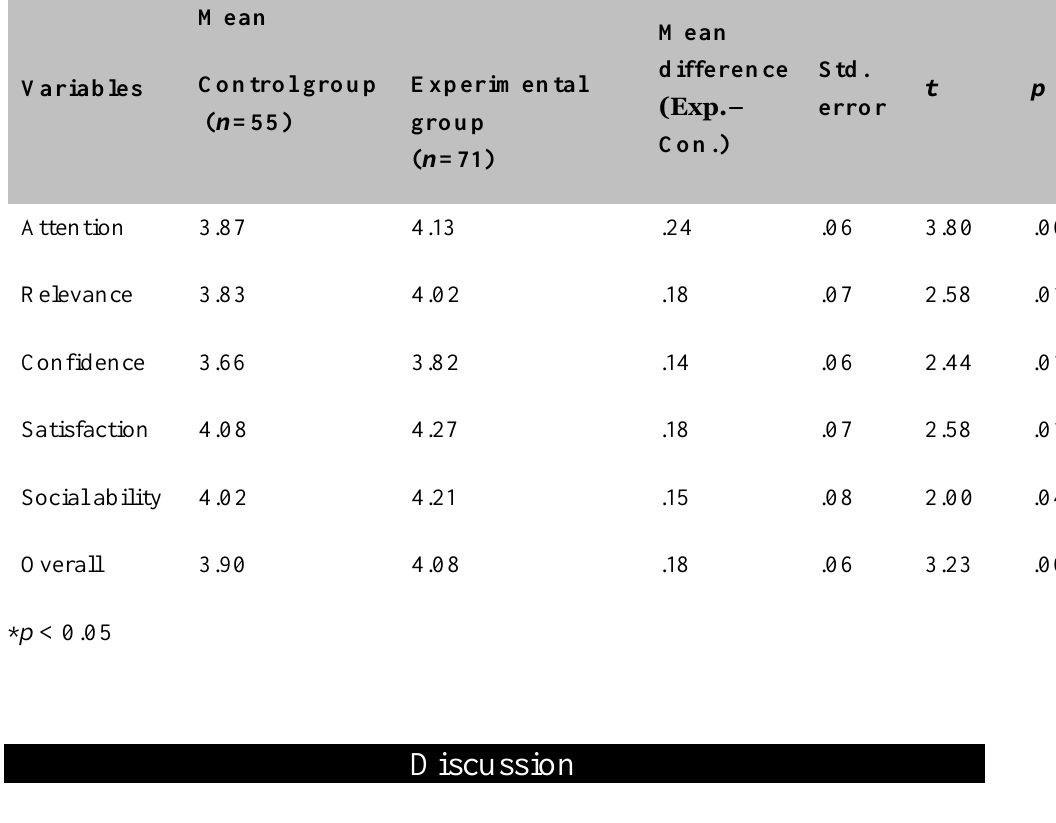
Comparison of Means of Subjective Measures by T-Test